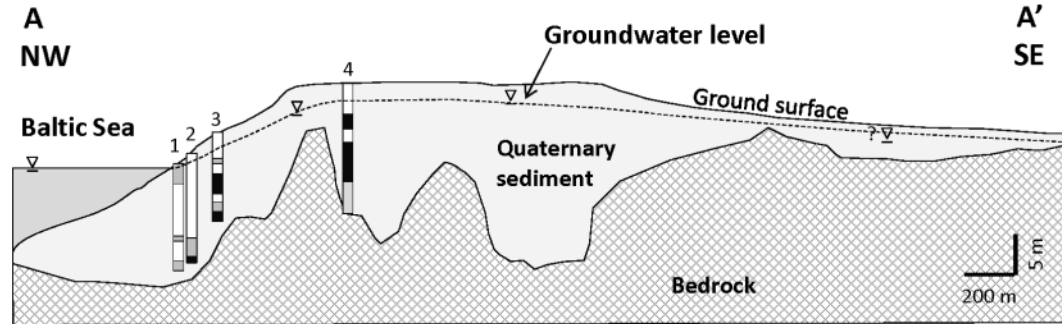
Figure 2. Geological cross-section along line A-A' (NW-SE direction) and sediments in observation wells